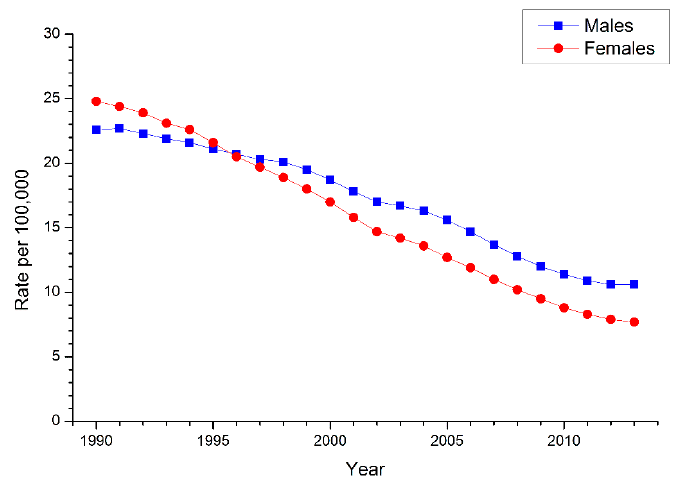
Figure 1. Trends of age-standardized suicide death rates per 100,000 population by gender in China, 1990–2013.